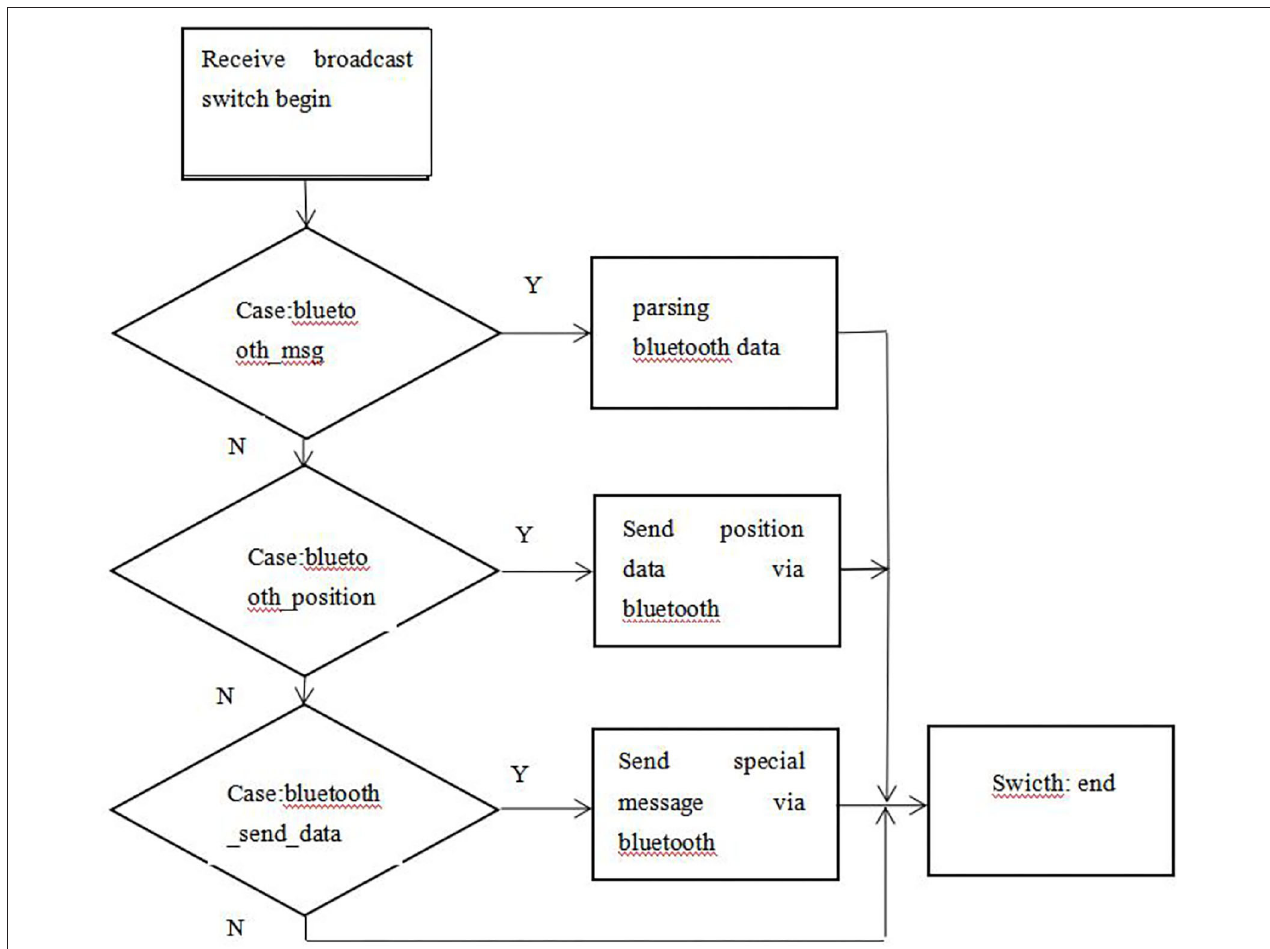
FIGURE 4 | Server receiving broadcast flow